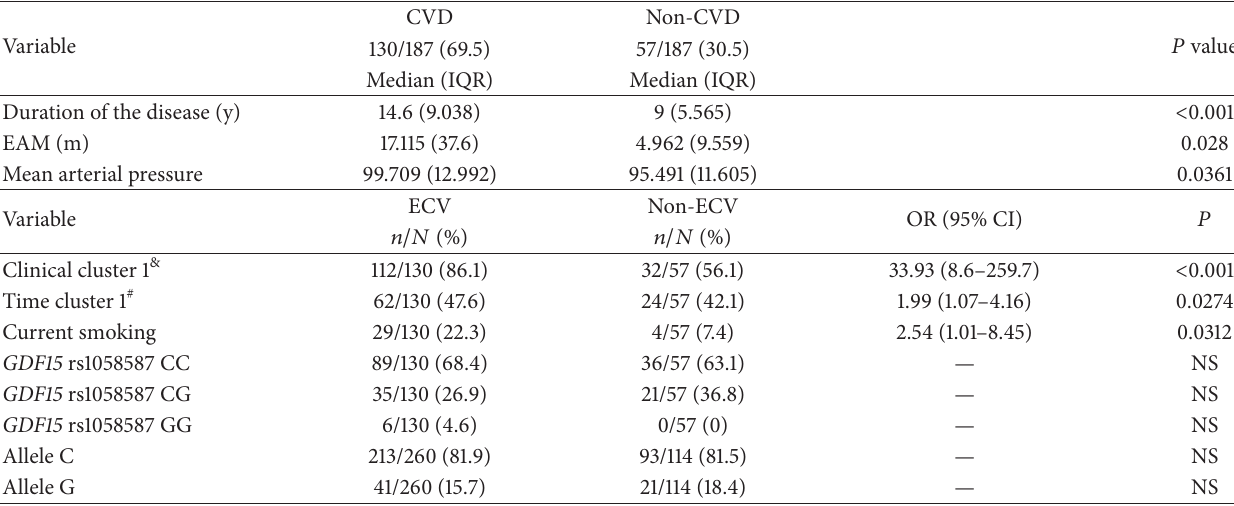
Table 3: Characteristics associated with CVD in RA patients.